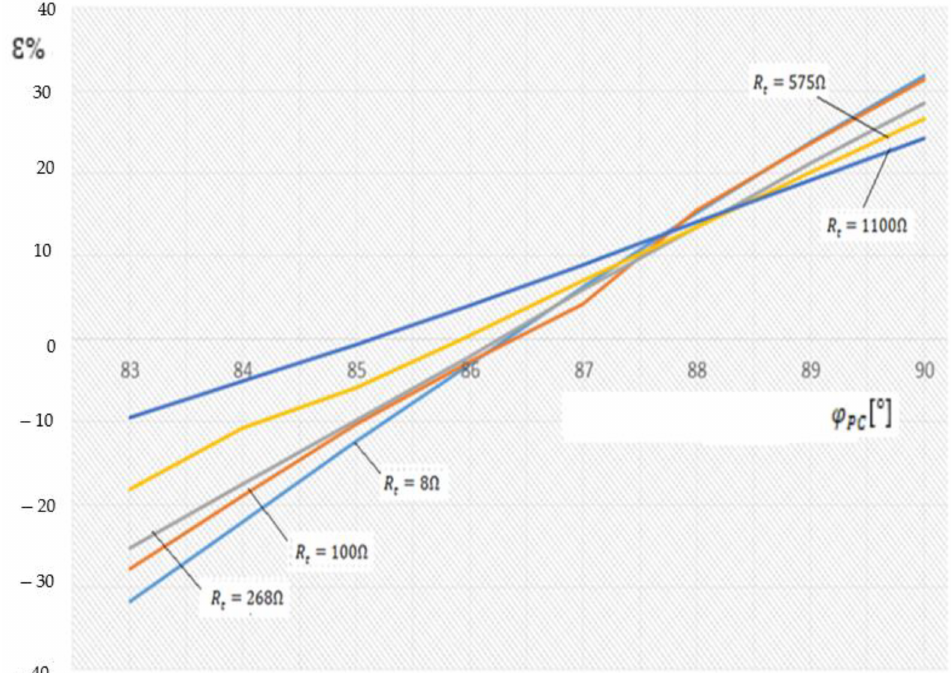
Figure 8. The dependence of difference between the effective values of the fault current, determined experimentally and analytically, and function on the difference phase between u PC and i PC , when ϕ c = 85.3 ◦ .